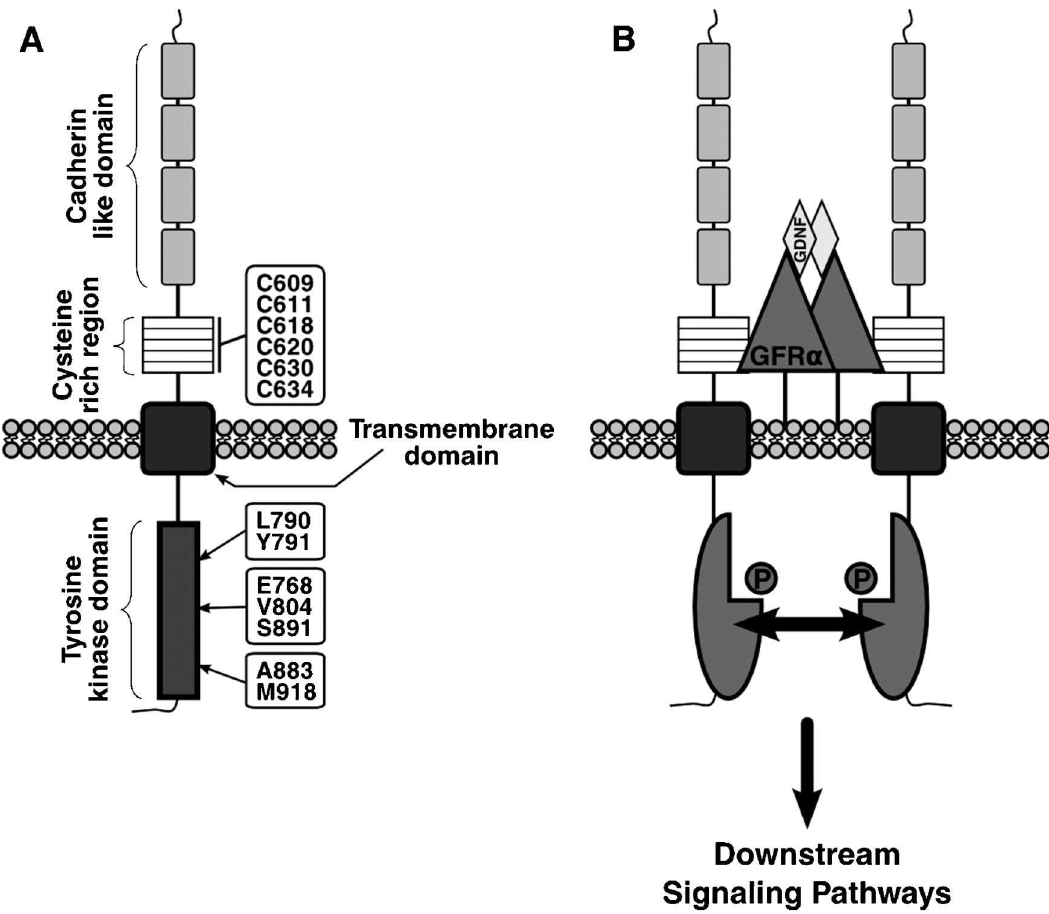
Figure 1 - The RET receptor: structure, activation, and oncogenic mutations. (A) Schematic diagram depicting RET tyrosine kinase receptor domains and the location of recurrent oncogenic mutations. The RET protein has a large extracellular domain containing a cysteine-rich region and a series of cadherin homology domains, a transmembrane domain, and an intracellular tyrosine kinase domain. The positions of the most common mutations found in patients with multiple endocrine neoplasia type 2 (MEN 2) are shown. (B) Mechanism of RET activation. Wild-type RET activation requires the dimerization of RET, mediated through formation of a multicomponent complex. RET is activated by binding both a soluble ligand (glial cell-line-derived neurotrophic factor; GDNF) and a non-signaling extracellular co-receptor (GDNF family receptor; GFR a ). Upon activation of RET, phosphorylation of multiple intracellular tyrosines leads to stimulation of downstream